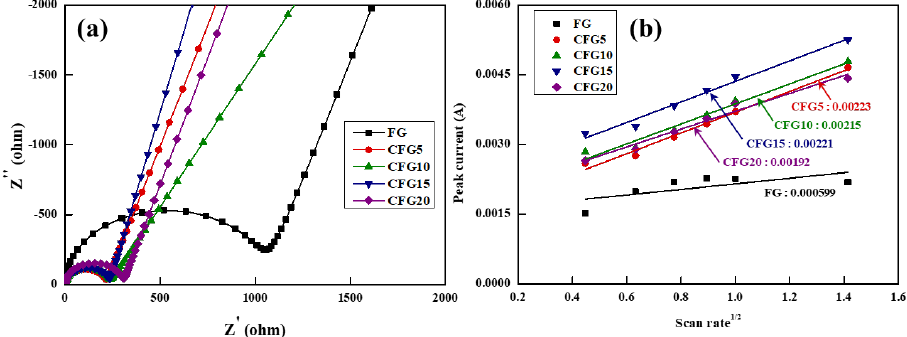
Figure 5. ( a ) Nyquist plot before 1st cycle and ( b ) the relationship between peak current and square root of scan rate based on cyclic voltammetry with various scan rate.